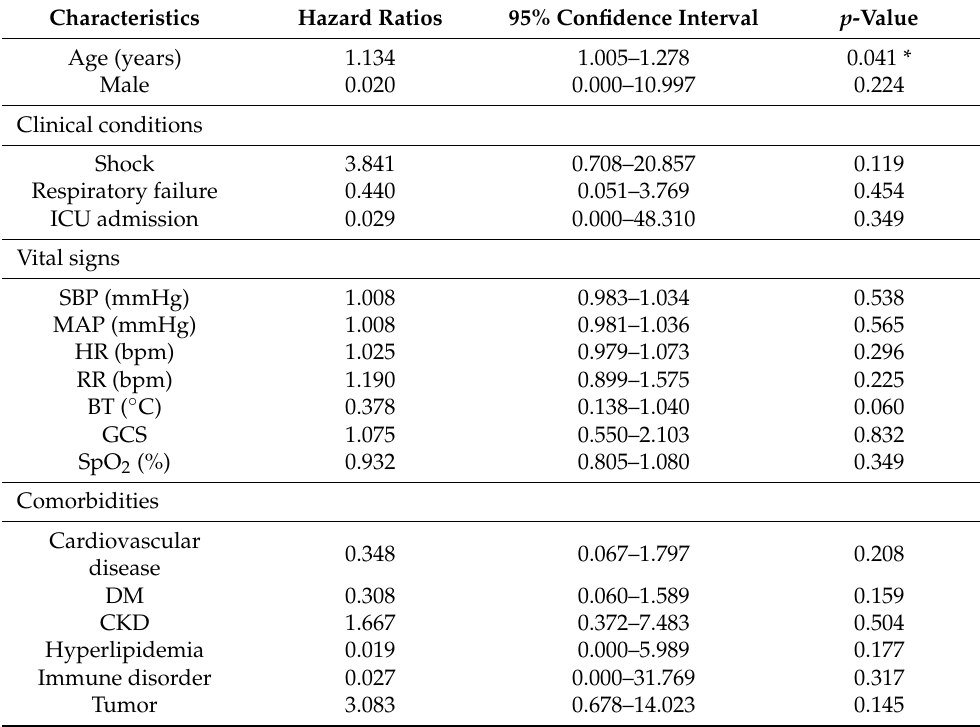
Table 4. Hazard ratios and 95% confidence interval of univariate analyses for emphysematous cystitis.